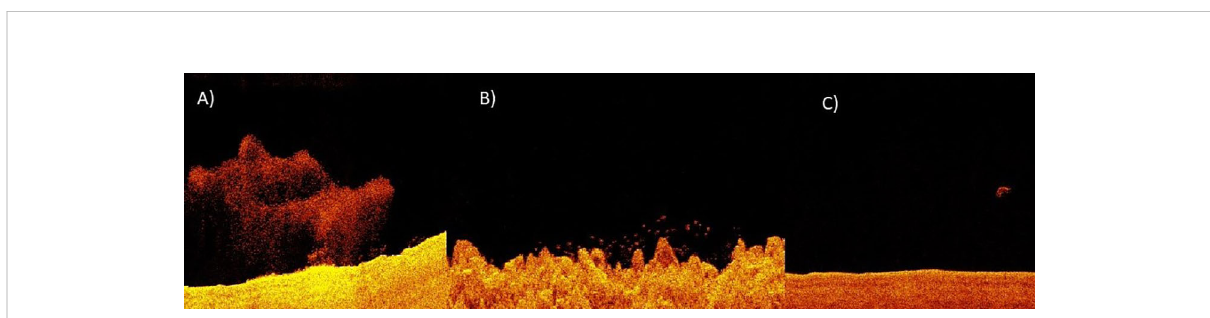
FIGURE 2 Sonar imaging depicting (A) an example of small schooling fi sh, de fi ned by water column detections that are dimensionless; (B) large fi sh, de fi ned by water column detections that are large enough to exhibit a distinctive shape; and (C) megafauna, de fi ned by solid water column detections that appeared to exceed 1m in any direction. Often it is not possible to distinguish the identity of megafauna, but they are likely to be large bony fi sh, sharks, rays, dolphins, turtles, or